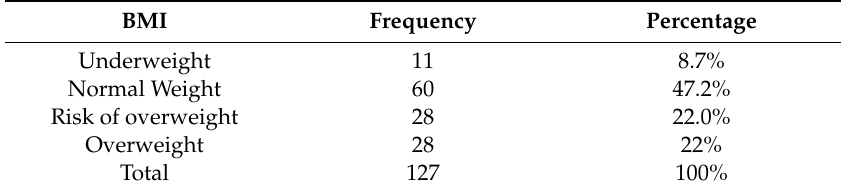
Table 1. Frequency and percentage of the sample, divided according to the weight curves. BMI